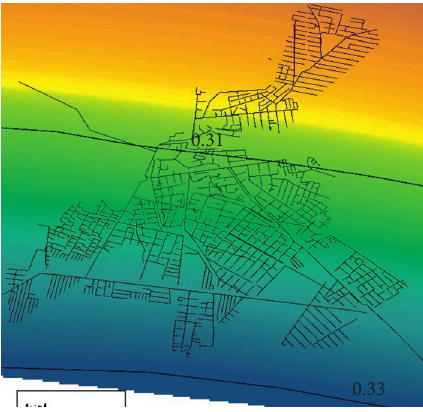
Figure 21: The PGA10 map and Borujen’s wastewater